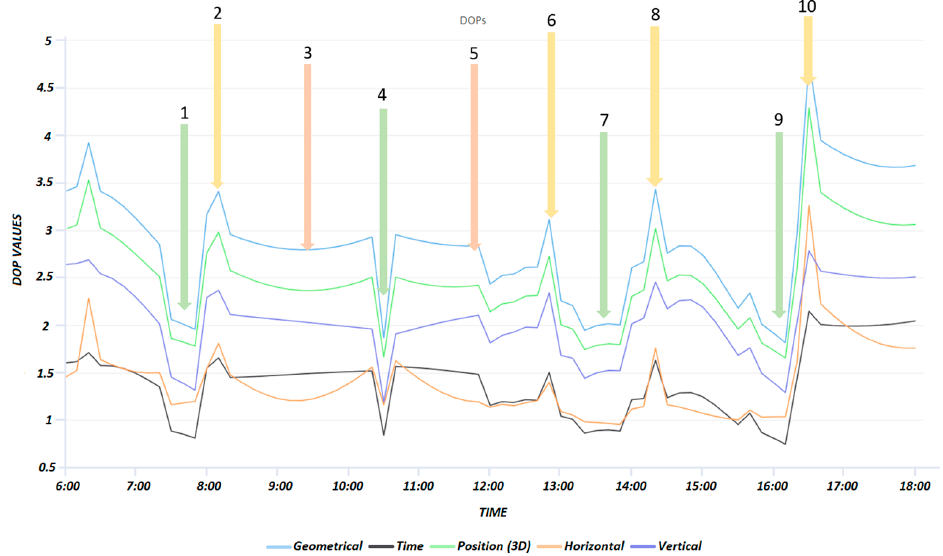
Figure 2. DOPs (Trimble GNSS Planning online) with times of planned observation sessions in the time window 06:00–18:00 CET (14 July 2020). The sessions planned are marked with numbers and arrows.